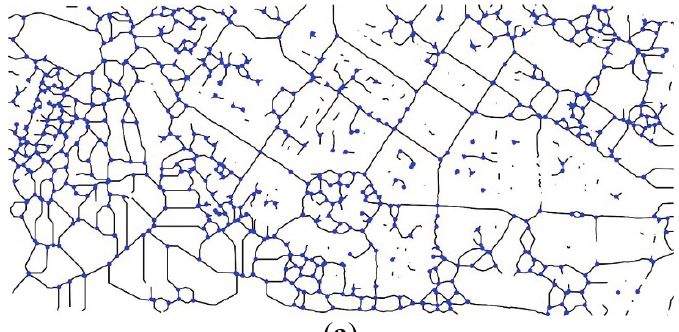
of the candidate nodes, where the blue solid dots represent the intersection points with at least three paths crossing; ( b ) the path network after removing the redundant nodes and segments, with the red solid dots representing the entrance and exit points; ( c ) the least-cost path determined on the basis of Dijkstra’s algorithm; the red solid dots represent the nodes of the determined